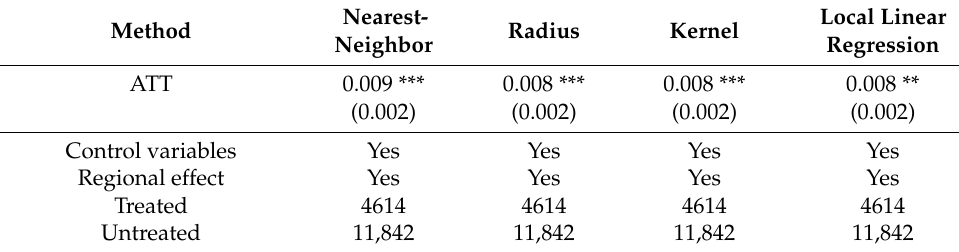
Table 6. PSM analysis of the impact of Internet use on divorce risk ( N =